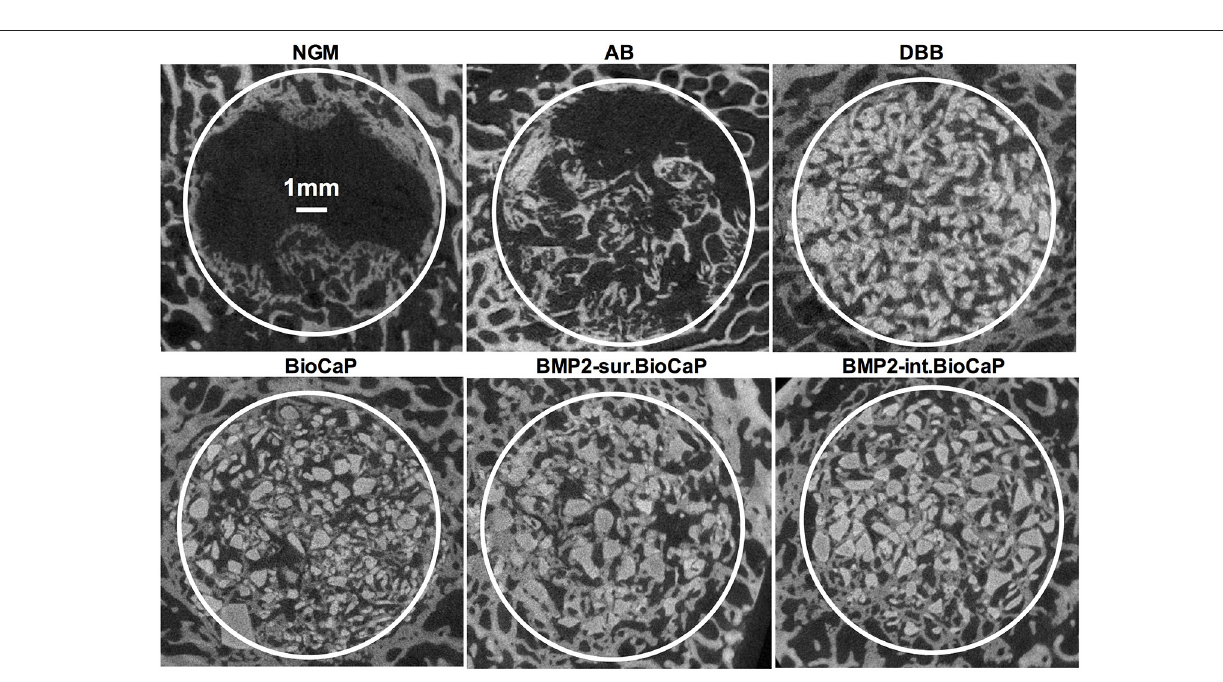
bone appearance, indicating active bone remodeling of woven bone in these groups. In both time points (week 4 and 8), it was difficult to recognize coating around the BMP2.BioCaP, indicating complete degradation of coating possibly by the effect of biological fluid or/and multinucleated giant